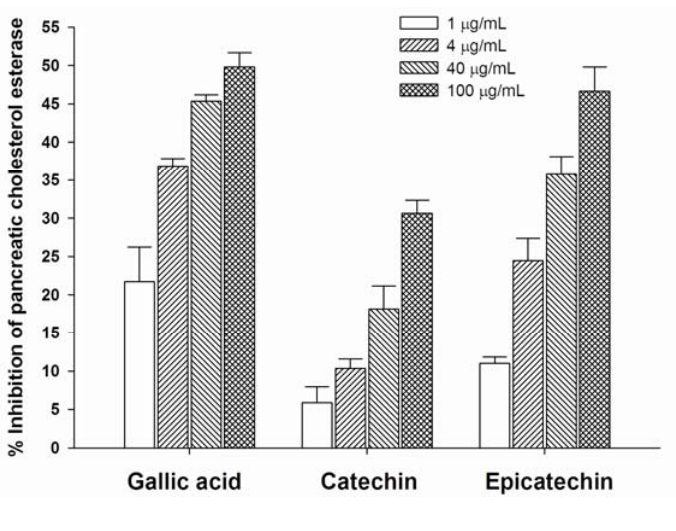
Figure 1. The inhibitory effect of gallic acid, catechin, and epicatechin against pancreatic cholesterol esterase. Results are expressed as mean ± S.E.M. , n =